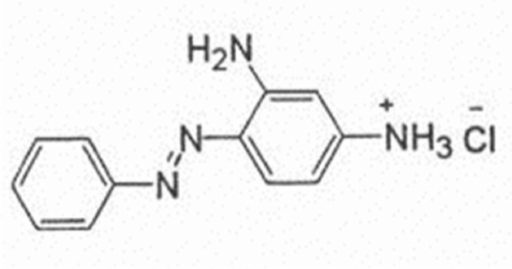
Figure 1. Chemical Structure of Basic Orange